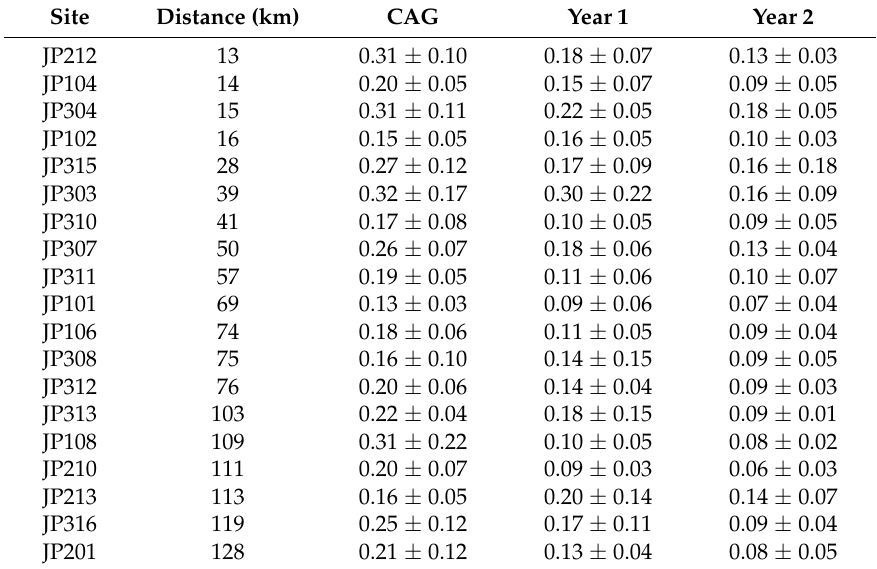
Table 2. (SO 4 -S)/(S org ) ratios (site averages and standard deviations) of jack pine needles in the